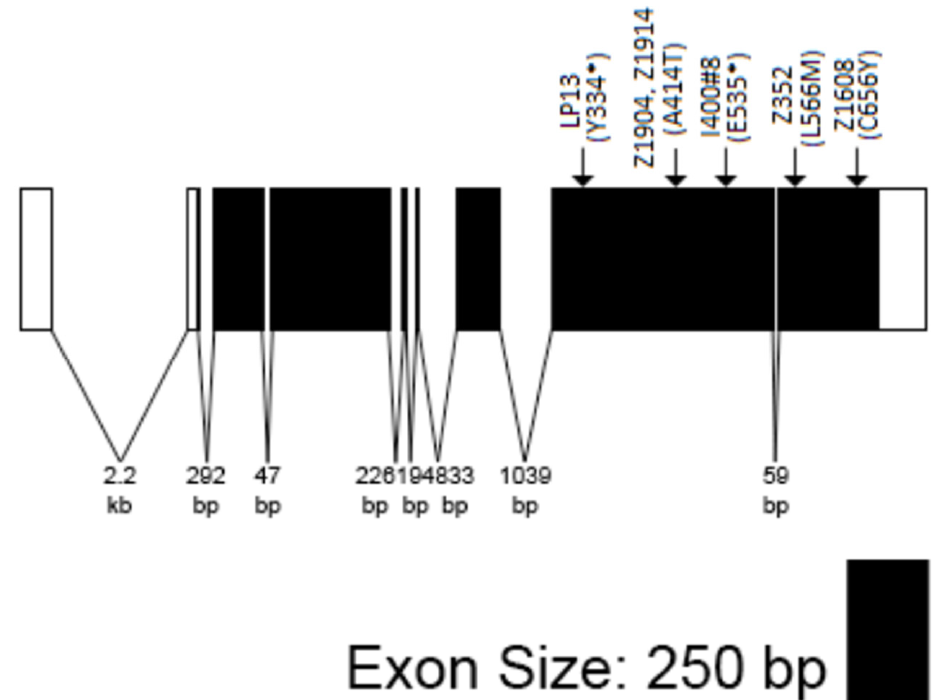
Figure 4. Transcript model of Gfat1-RN . Locations of mutations are given above and are marked by arrows along the gene model. zep LP13 and zep I400#8 contain stop codons (indicated by asterisks) after Tyr334 and Glu535, respectively; zep z1904 and zep z1914 contain the identical missense mutation, A414T; zep 3 − 52 contains the missense mutation, L566M; and zep z1608 contains the missense mutation,